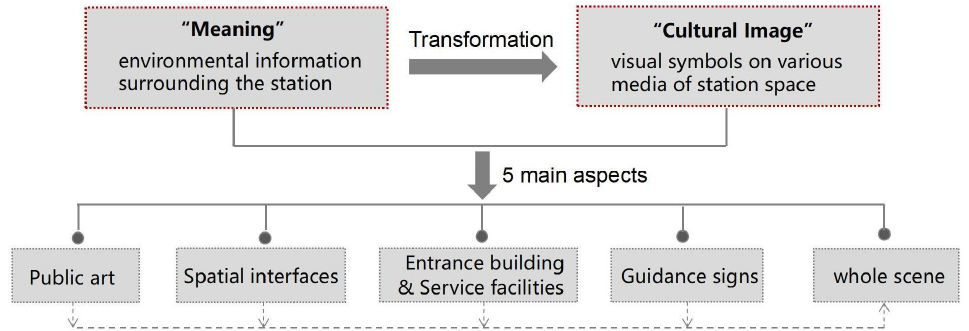
Figure 1. Transforming “meaning” into